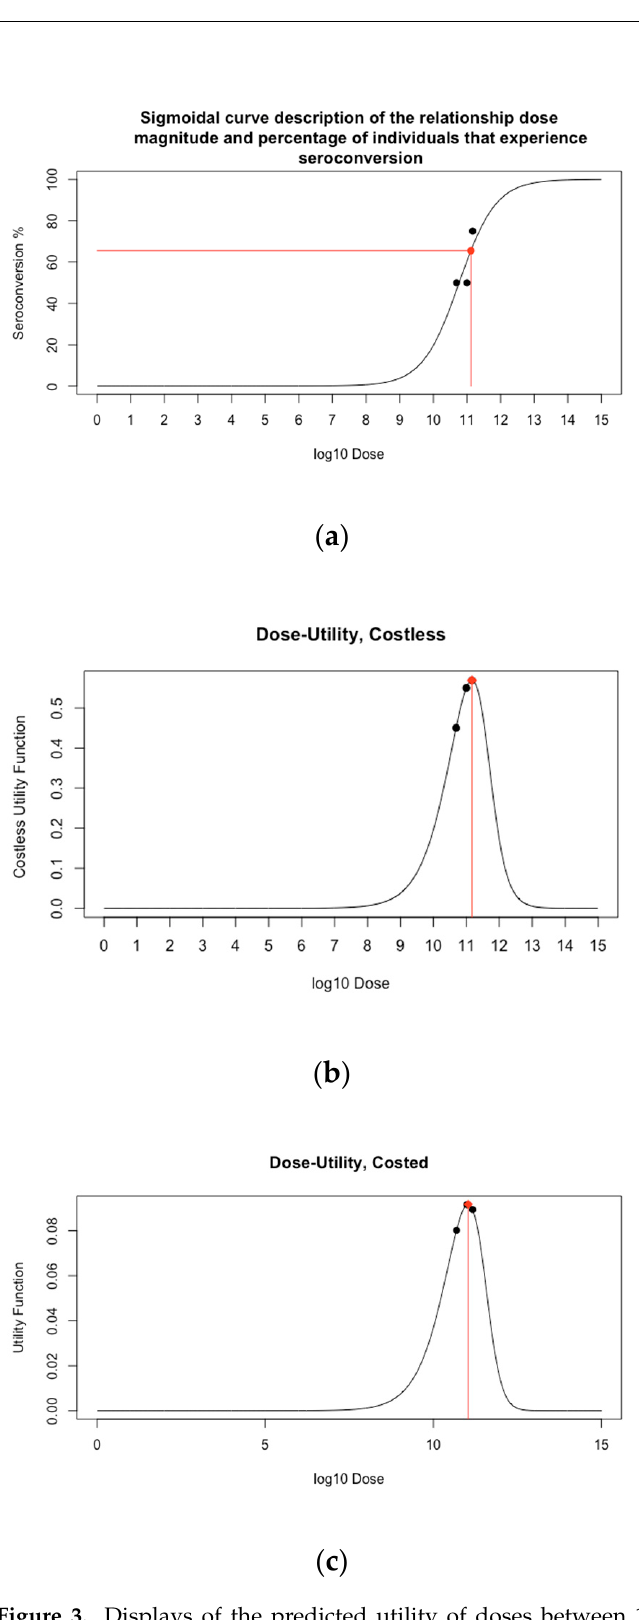
Figure 3. Displays of the predicted utility of doses between 10 0 and 10 15 VP. ( a ) shows dose-seroconversion, with the horizontal red line indicating the 65.5% seroconversion threshold required for herd immunity. ( b ) shows the relationship between dose and the costless utility function and ( c ) shows the relationship between dose and the costed utility function. The black dots represent Table 1. 3 × 10 11 , ( b ) 1.5 × 10 11 VP and ( c ) 1.1 × 10 11 VP.